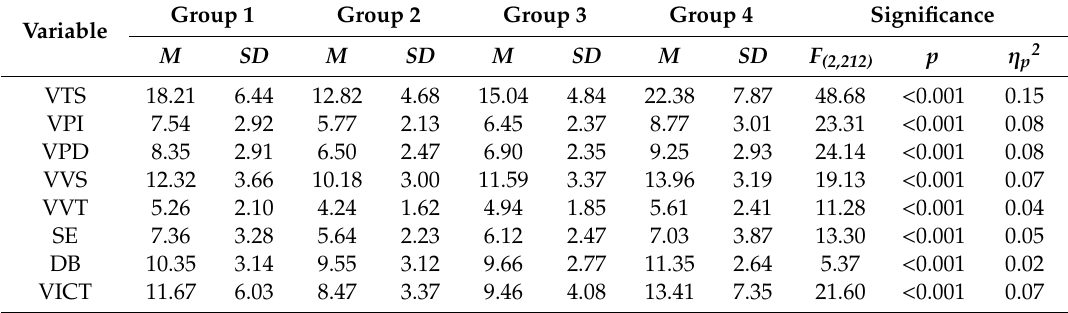
Table 3. Means and standard deviations obtained by the profiles di ff erent types of intrapersonal and interpersonal and values of the eta 2 parcial ( η p2 ) for each variable of school violence.